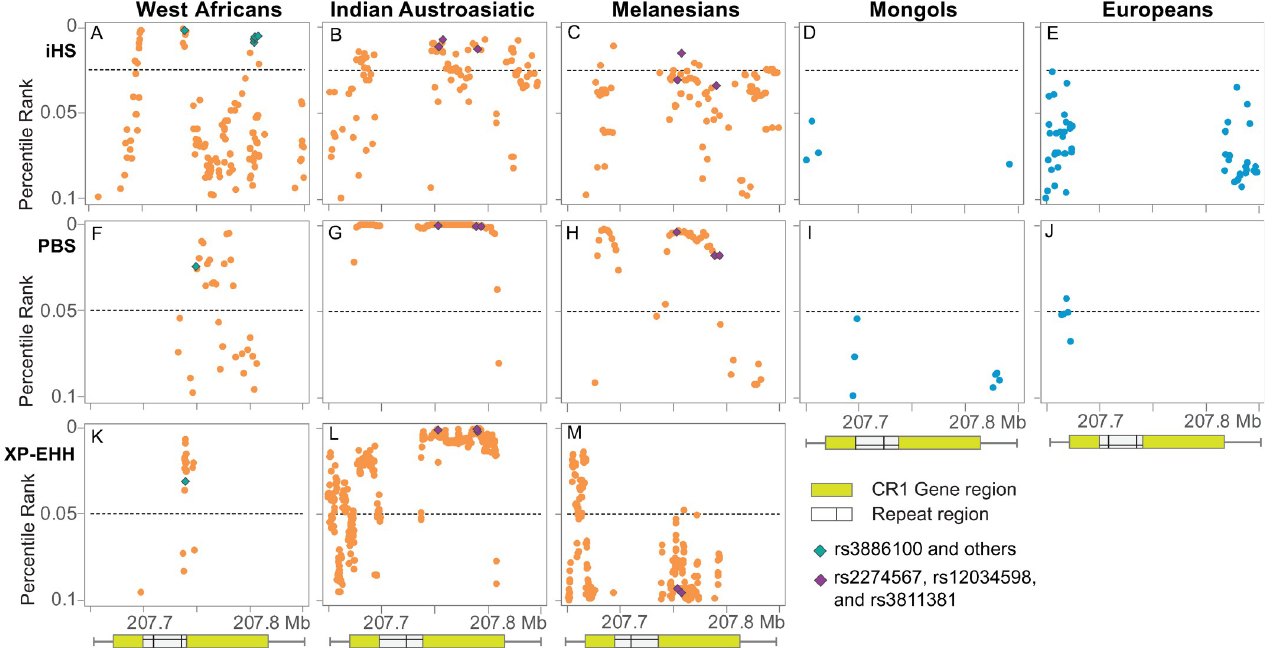
Fig 2. Genome-wide percentile ranking of three selection tests. The standardized iHS [34] (A, B, C, D, and E), PBS [35] (F, G, H, I, and J), and XP-EHH [33] (K, L, and M) values across the CR1 gene region (50kb upstream and downstream) are plotted for the five population groups (three endemic and two non- endemic). The XP-EHH results were the three endemic population groups versus Mongols. The two non-endemic PBS results (I and J) are plotted from the tests for Indian Austroasiatic populations, Mongols, and Europeans. Dots represent SNPs (iHS and XP-EHH) or windows (PBS) having percentile ranking values equal to or lower than top 0.10 (Y axis) over the Mbp position on chromosome 1 (X axis). The CR1 gene and repeat region on the X axis are indicated as green and mesh bars under the plots, respectively. Across the three methods, here we show SNPs with a percentile ranking equal to or lower than 0.1 for the endemic and non-endemic population groups. In addition, green and purple diamonds indicate the SNPs/windows associated with the CR1 expression level (rs2274567, rs3811381, rs3886100, rs11803956, rs12041437, rs17186848, and rs11803366) and erythrocyte sedimentation rate (rs12034598).